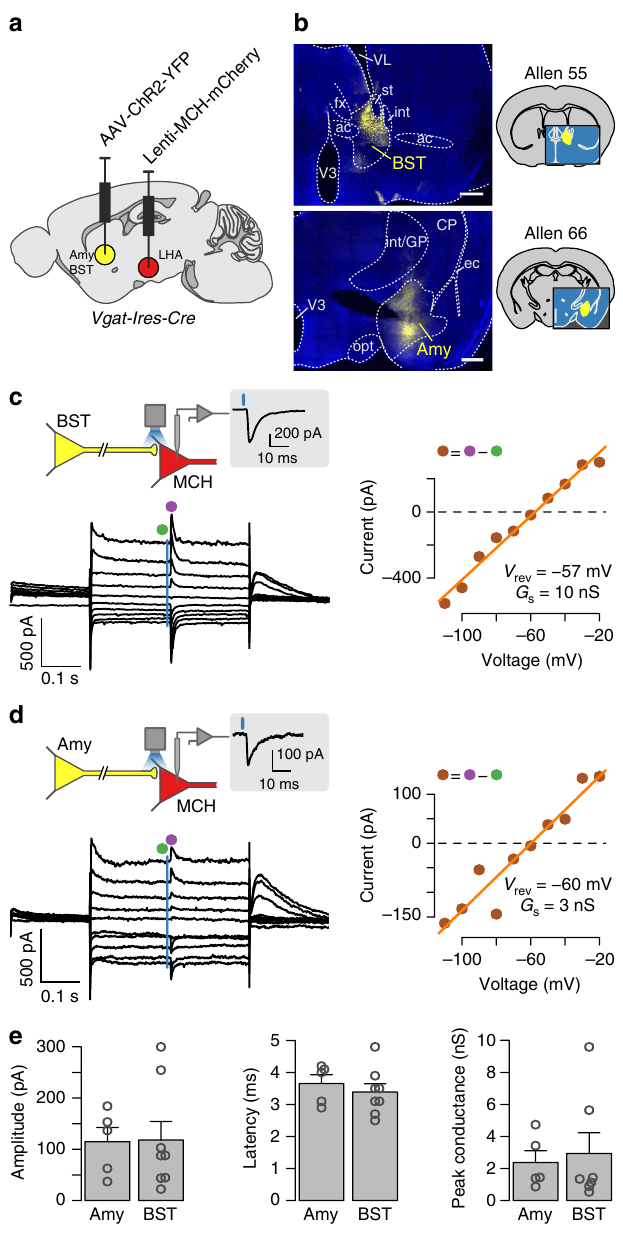
(Supplementary Fig. 2a,b) was performed with ANY-maze software. To control for circadian factors, the experiments were performed either at the